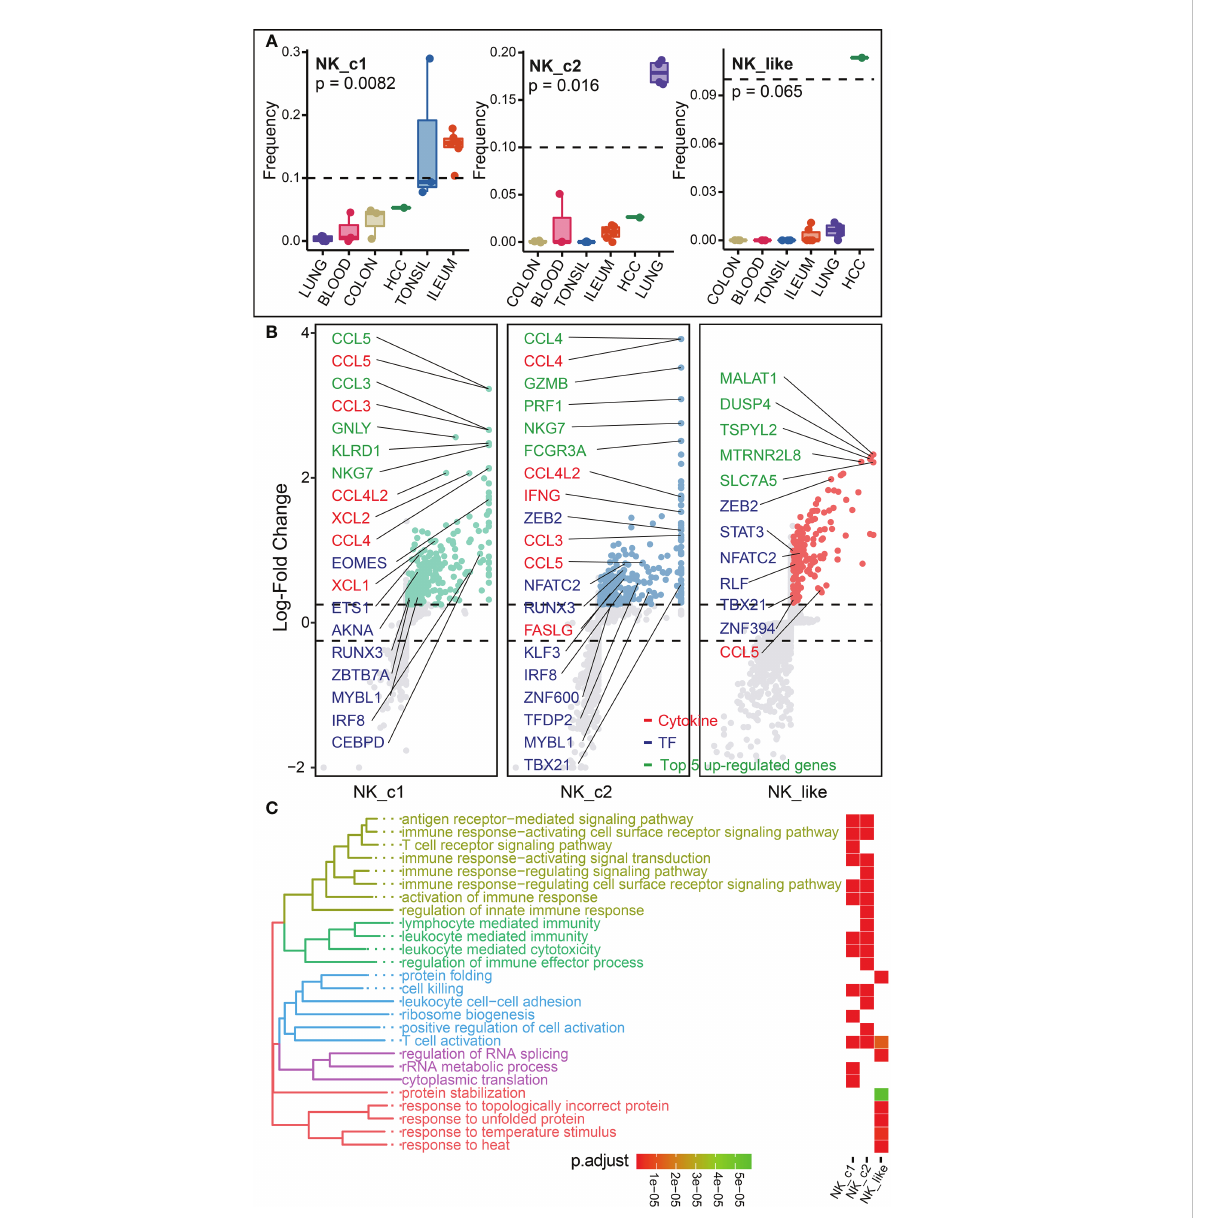
FIGURE 6 Characterization of NK and NK_like cells in different tissues. (A) Box plots showing the frequencies of four NK subsets (divided by the total ILC number) in lung, colon, ileum, tonsil, blood and HCC. P values were calculated from Kruskal-Wallis test. (B) Differential gene expression analysis showing up- and down-regulated transcripts across three NK subsets. (C) Functional enrichment analysis showing top 15 GO terms in each NK subset of biological